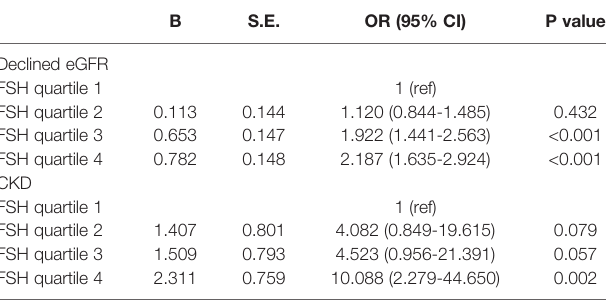
TABLE 4 | Multivariate stepwise logistic regression of FSH quartiles for the presence of renal dysfunction in postmenopausal women. B S.E. OR (95% CI) P value